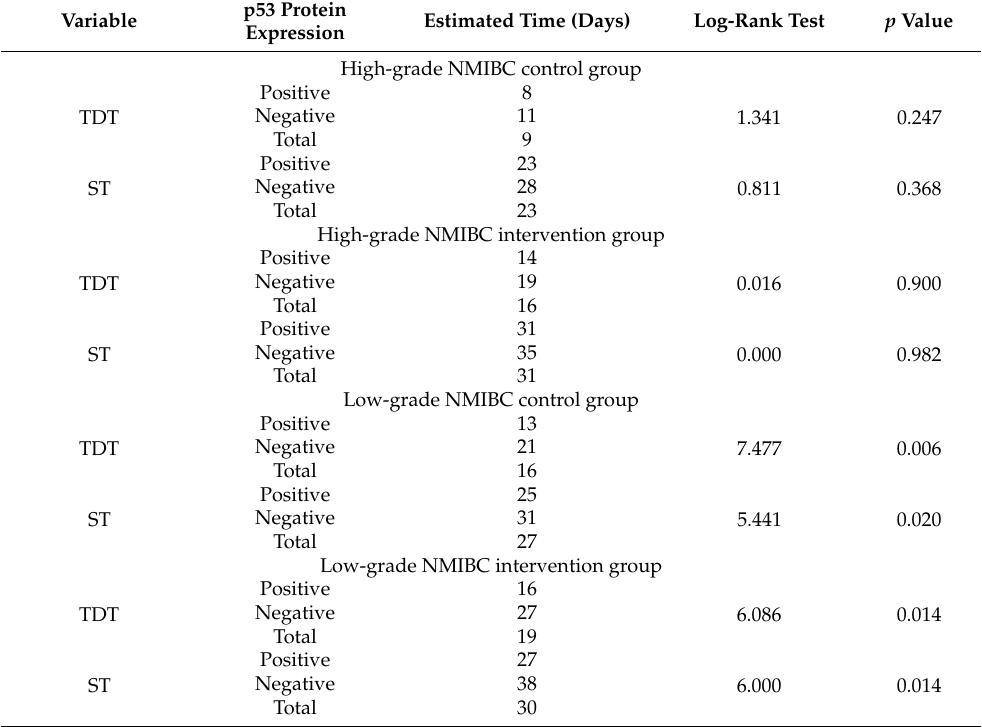
Table 3. Association between p53 protein expression and animals’ survival and tumor-doubling time in control and interventional groups (single-factor log-rank test).